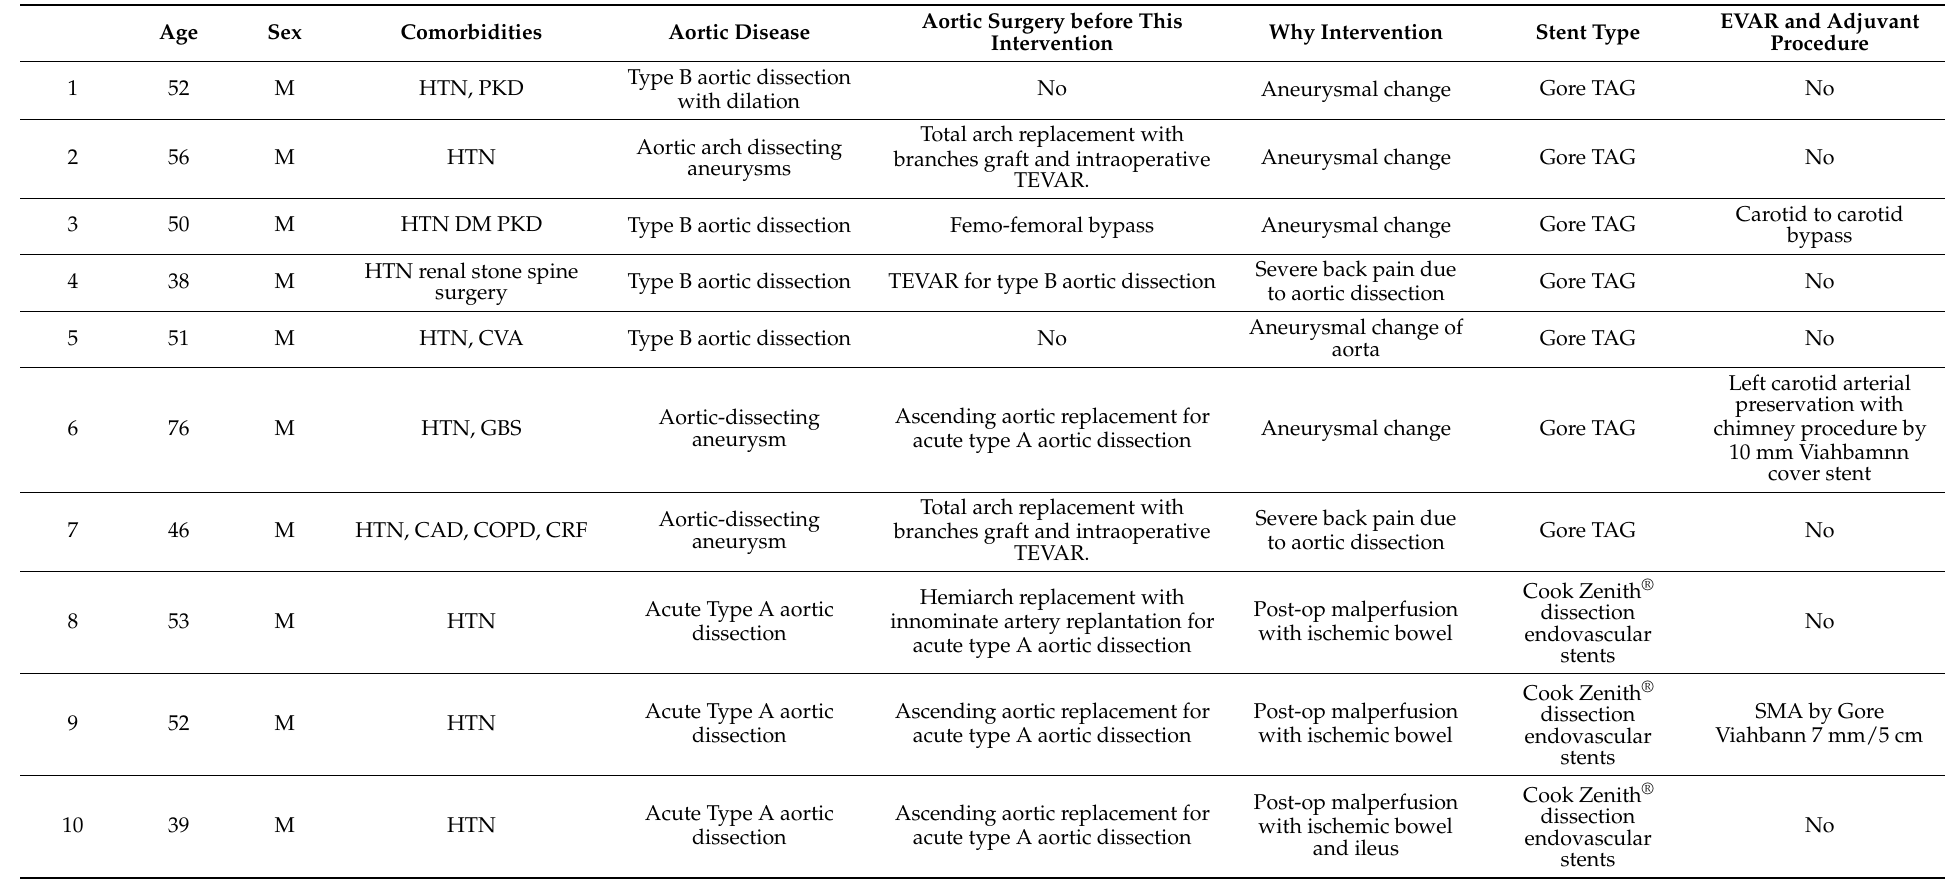
Table 1. Demographic of 10 patients receiving 4D PC MRI before and after endovascular aortic